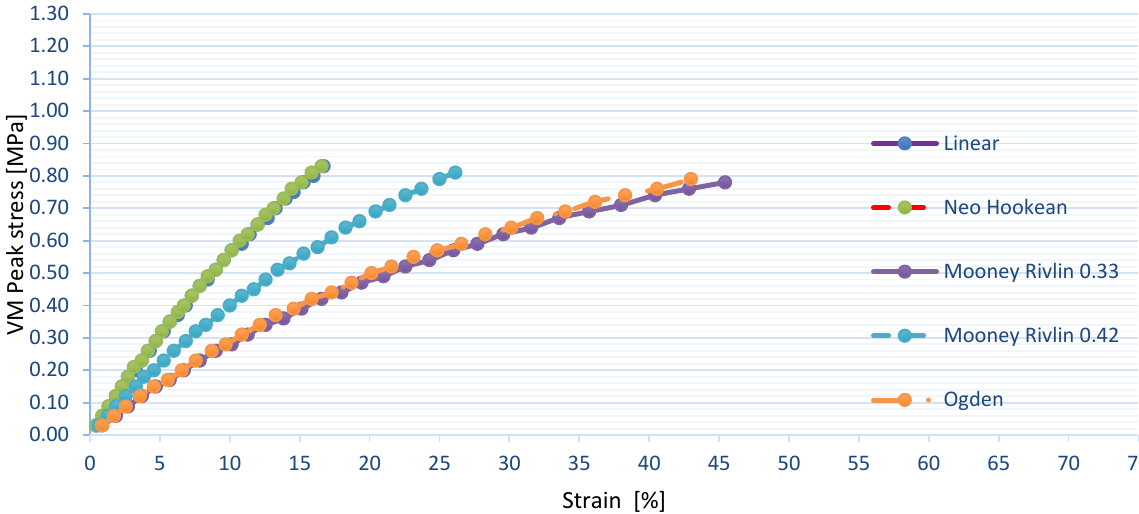
VM Peak Axial Stress vs Strain of 1:1 silicone